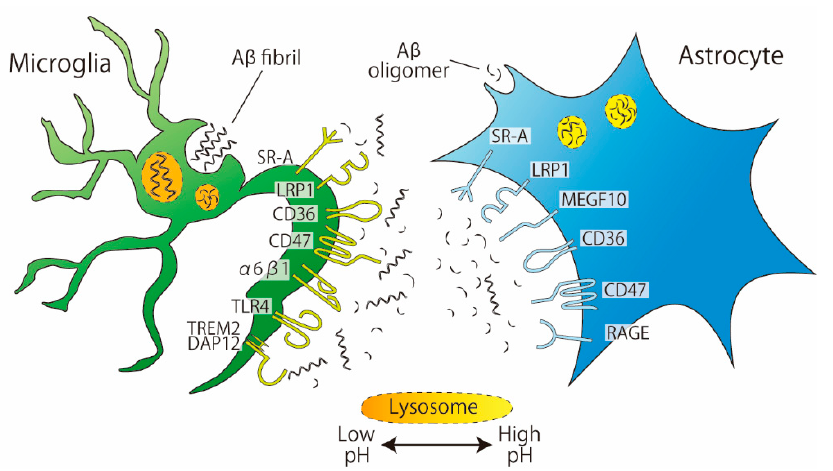
Figure 2. Phagocytosis of A β by microglia and astrocytes. A β fibrils are phagocytosed more by microglia than by astrocytes. Microglia and astrocytes share the same receptors for A β phagocytosis: SR-A, LRP1, CD36, and CD47. MEGF10 are expressed in astrocytes. The pH of microglial lysosomes is lower than that of astrocytes.